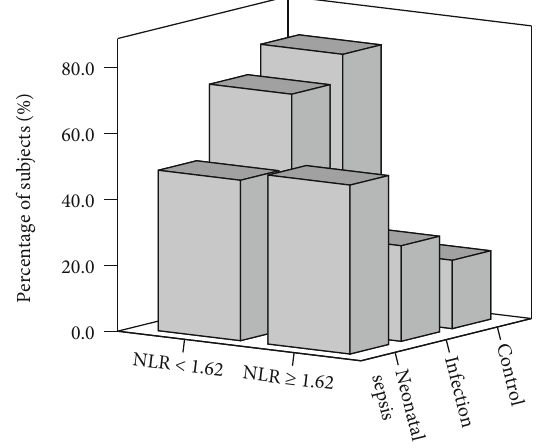
Figure 3: The distribution of subjects in high ( ≥ 1.62) or low ( < 1.62) NLR